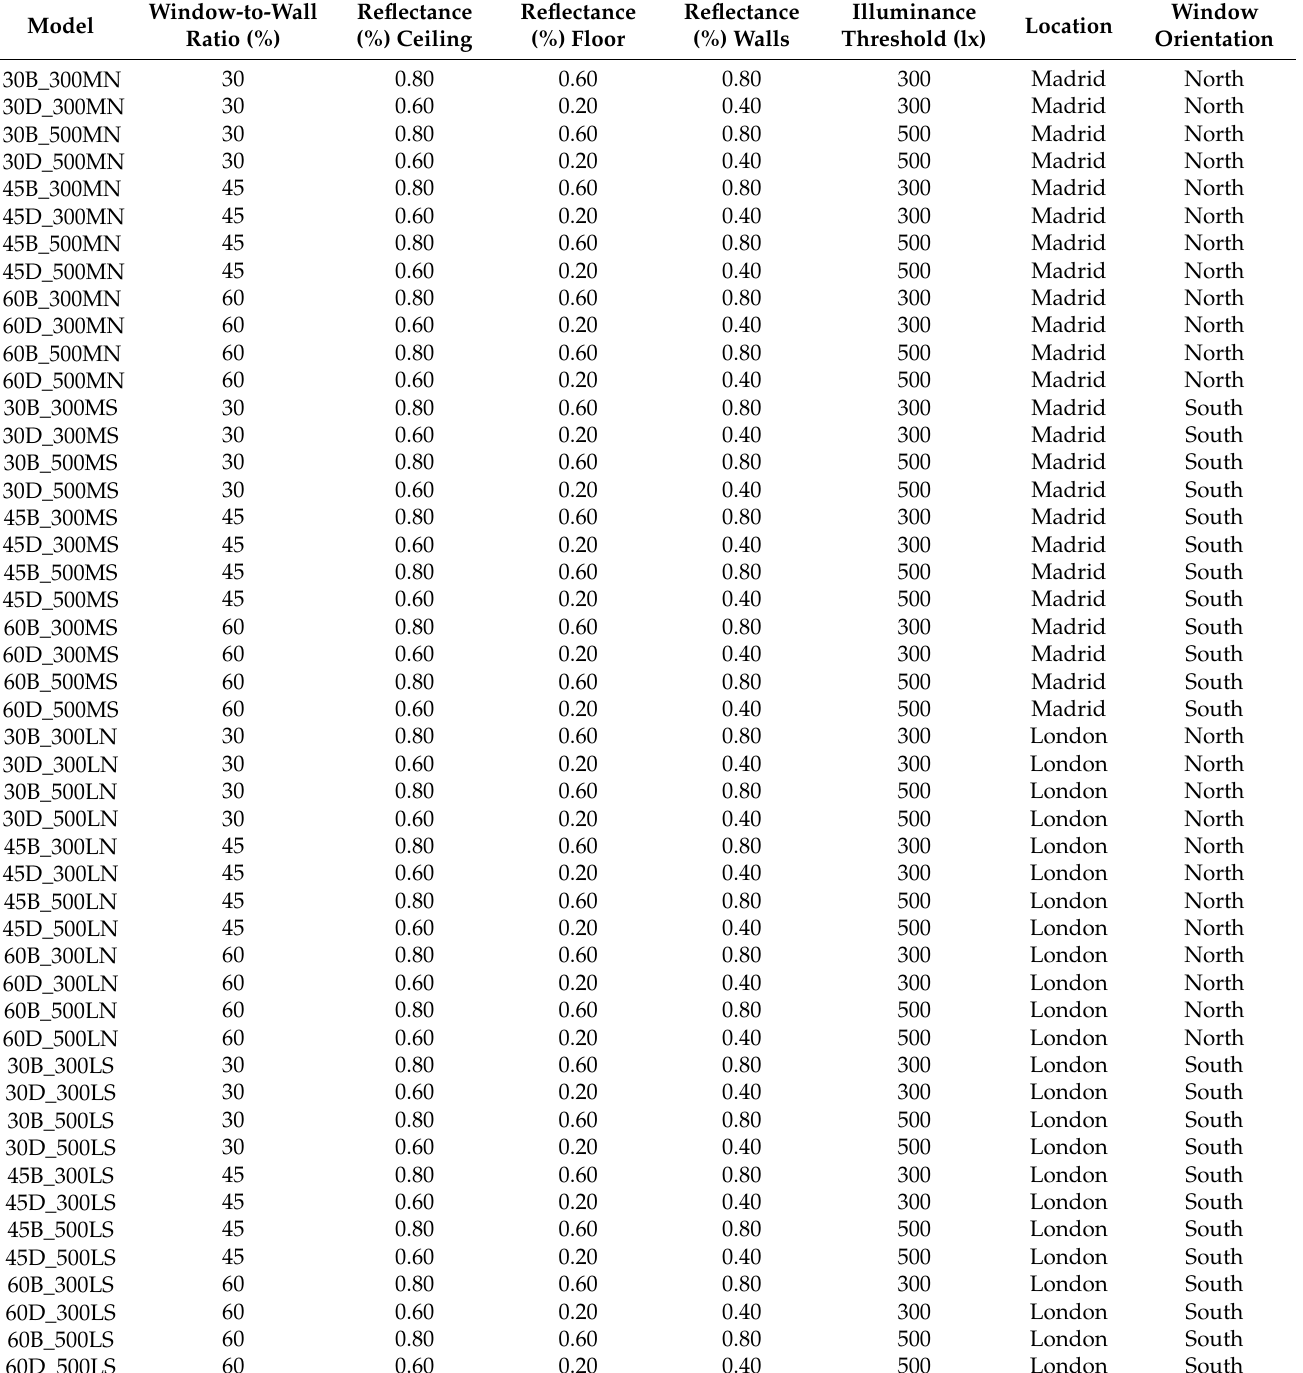
Table 2. Calculation models according to defined